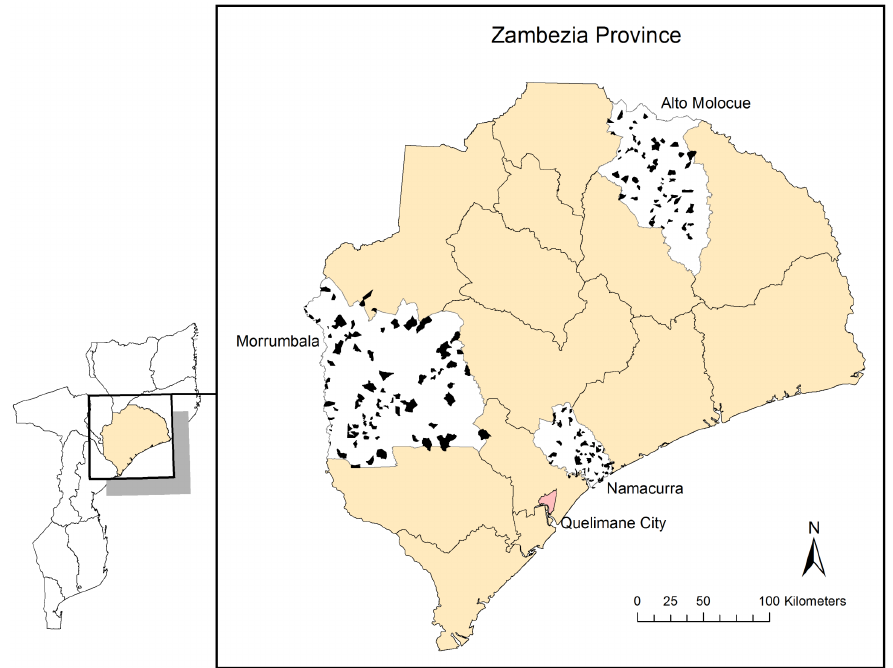
Figure 1. Map of Mozambique, Zambe´zia Province, with Enumeration Areas Highlighted in Three Focus Districts, Namacurra, Morrumbala, and Alto Molo´cue`.